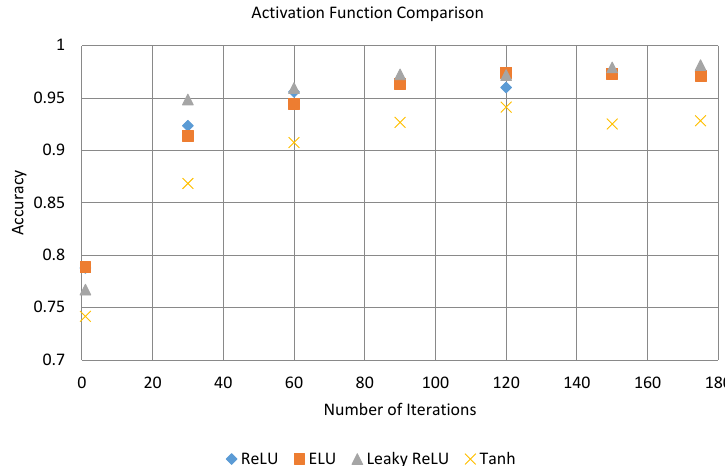
Fig. 1: Comparison of the activation function